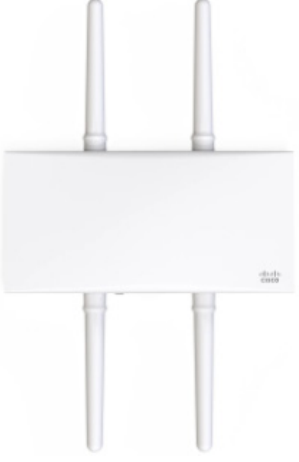
Figure 2. Cisco/Meraki ‘MR76 ′ —Outdoor Wi-Fi & BLE Access Point.